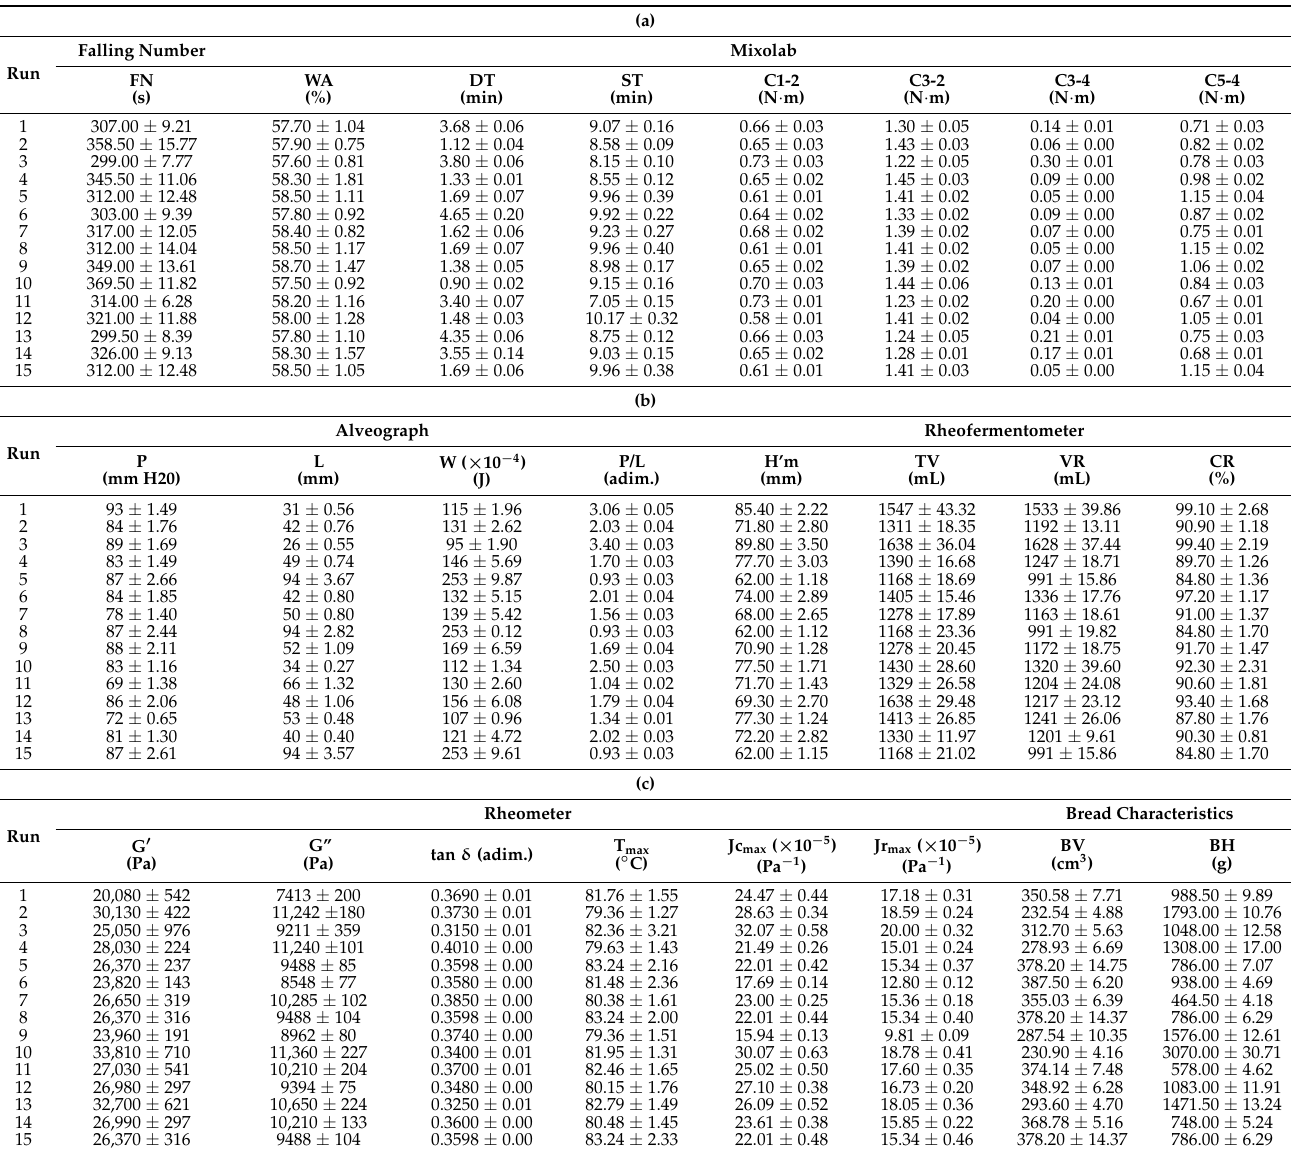
Table 1. Effects of PS and BF addition level on: ( a ) falling number and dough Mixolab